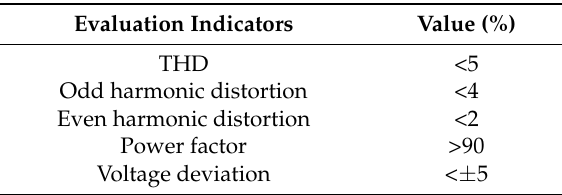
Table 1. Codes of Power Quality